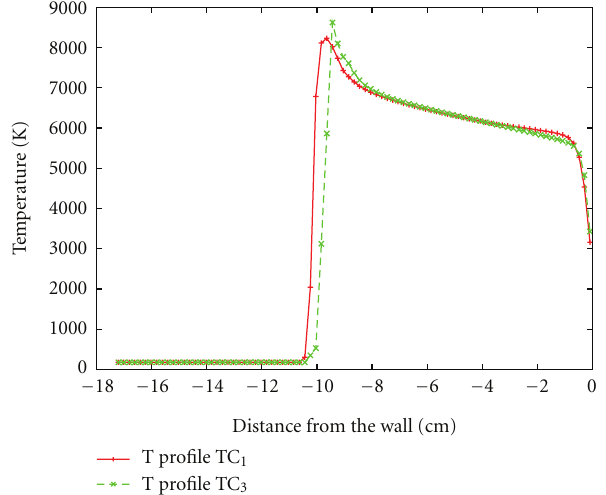
Figure 10: Temperature profiles among stagnation line for TC 1 and TC 3 .